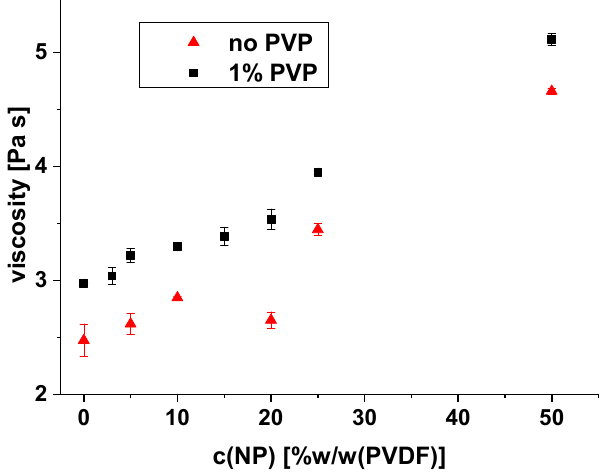
Figure 1. Effect of ZnO nanoparticle content on the viscosity of dope solutions consisting of PVDF in NMP, with and without PVP; measured at 15.9 s −1 and 20 °C.